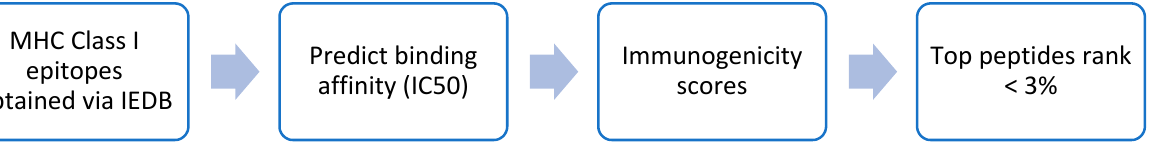
Figure 1. IntegralVac’s MHC Class I data selection process workflow. IntegralVac initially obtains epitopes using the IEDB analysis and search tool. The epitopes are then used as input in IntegralVac to generate binding predictions (IC50 values) for each peptide. We generate immunogenicity scores for all peptides using predictor characteristics of the peptide that may include amino acid sequence, antigenicity, allergenicity, and toxicity values. Most top peptides are selected based on their near or below 3% percentile ranking values. After selection, IntegralVac was utilized to compare the top-ranking peptides with results from the NetMHCPan EL server. Unlike the other datasets, MHC Class I data did not use each peptide’s antigenicity, allergenicity, and toxicity values as predictors.